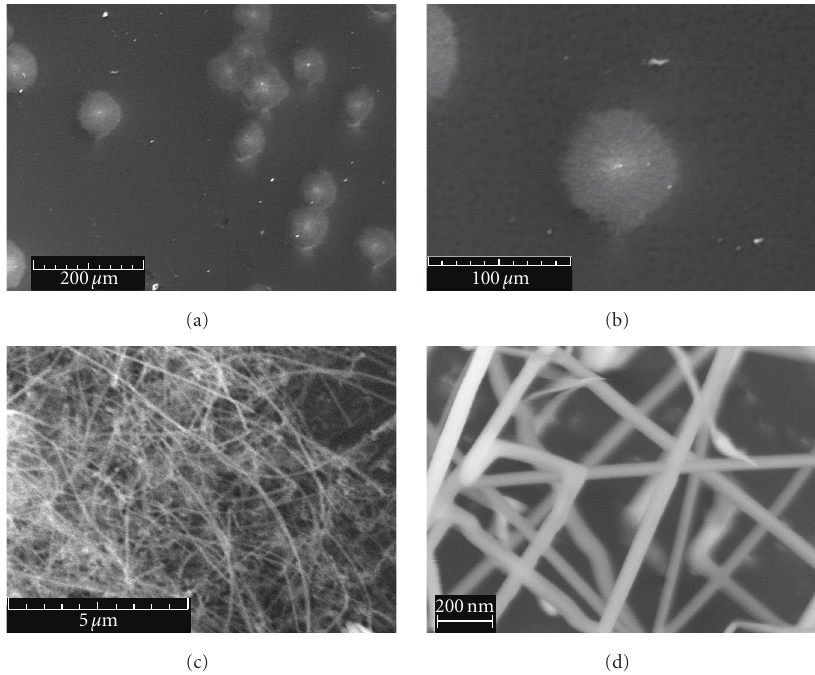
Figure 1: A view of the produced material: (a) Clusters of nanowires on Au seeds, (b) One cluster of nanowires, (c) A detailed SEM image inside a cluster. (d) Nanowires of diameter ≈ 30